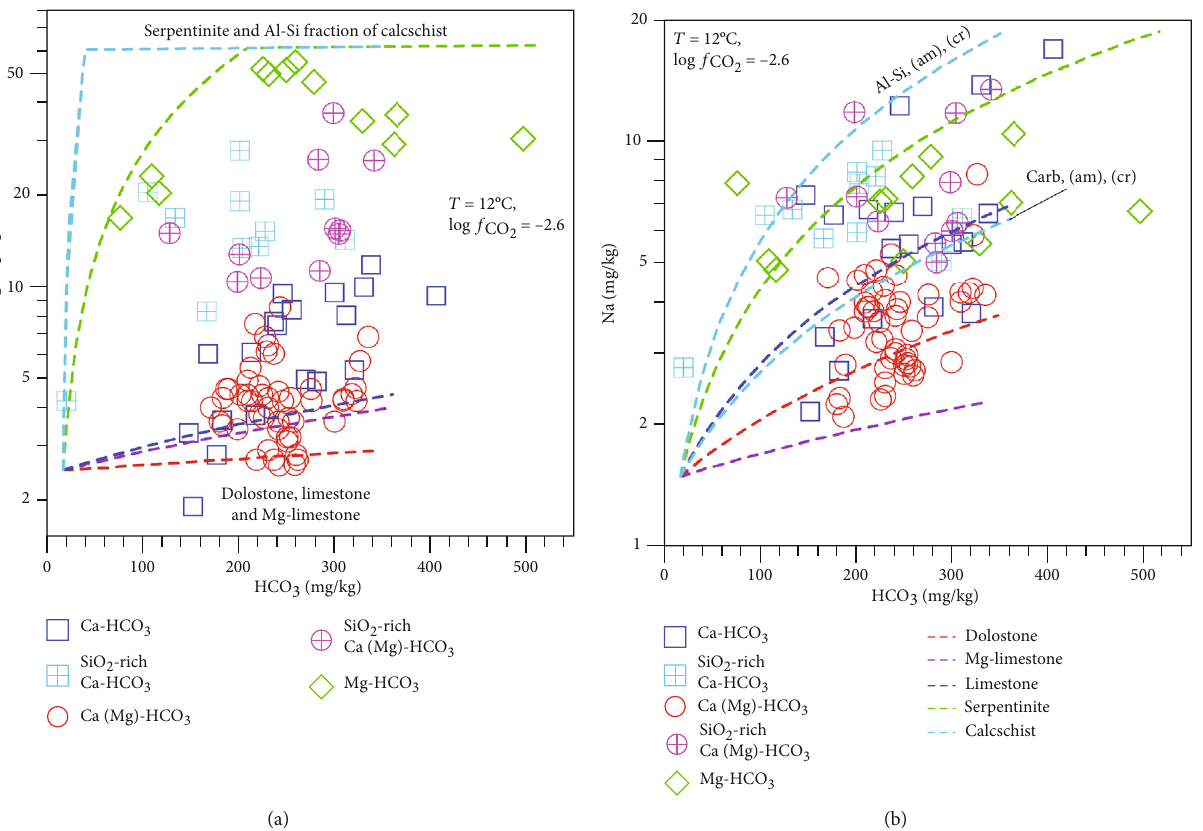
Figure 6: Correlation diagrams of alkalinity (expressed in mg HCO di ff erent rocks (see legend) according to the simulations elaborated in this